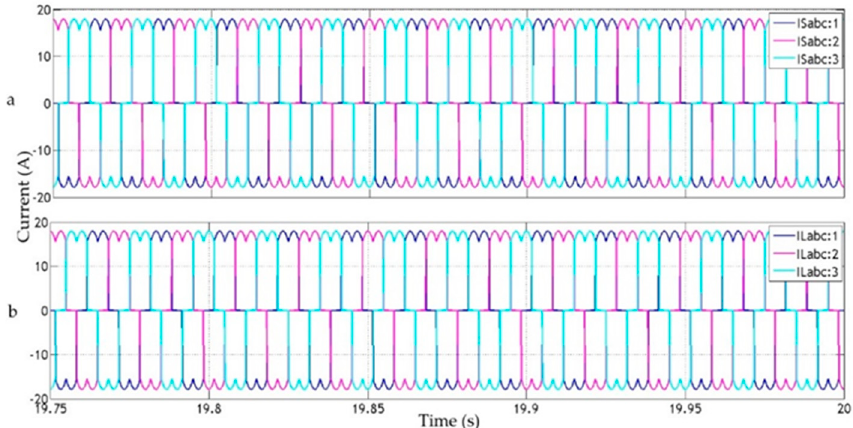
Figure 8. Before compensation ( a ) source current; ( b ) load current.